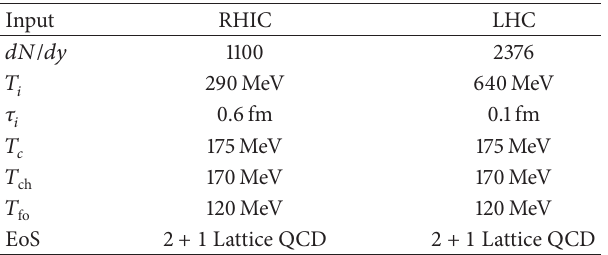
Table 3: Values of the various parameters used in the relativistic hydrodynamical